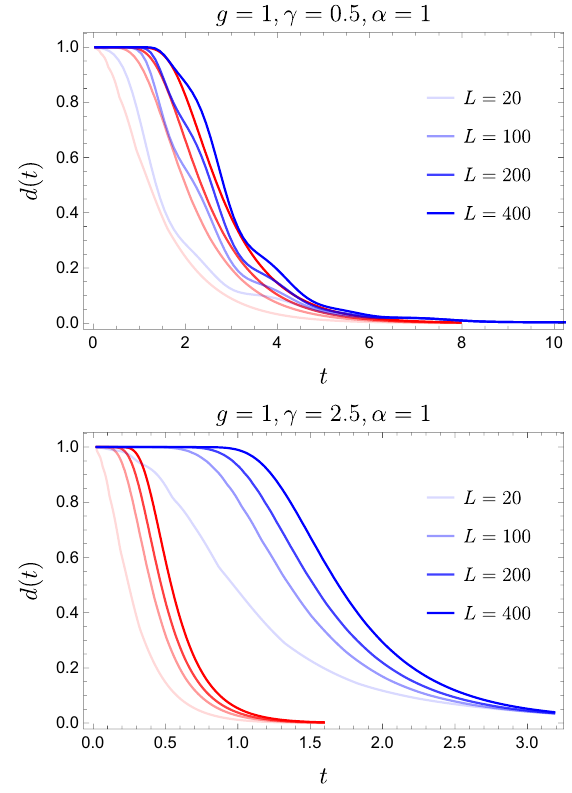
Figure 7: Distance to equilibrium in the topological model for the Ising chain in zero magnetic field ( α = 1, h = 0) starting from two different classes of initial states, in the regimes γ > 2 g , γ < 2 g and for different sizes L . The blue curves correspond to the least mixed state at all time (“worst choice” initial conditions), while the red curves correspond to a product of single-sector commuting matrices, which for γ > 2 g seems to be the fastest-mixing